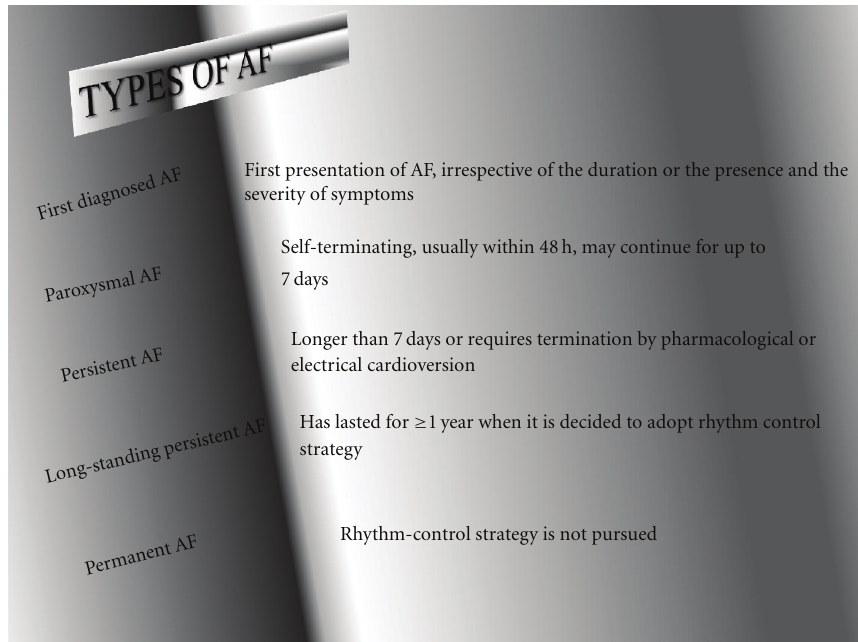
Figure 1: Classification of atrial